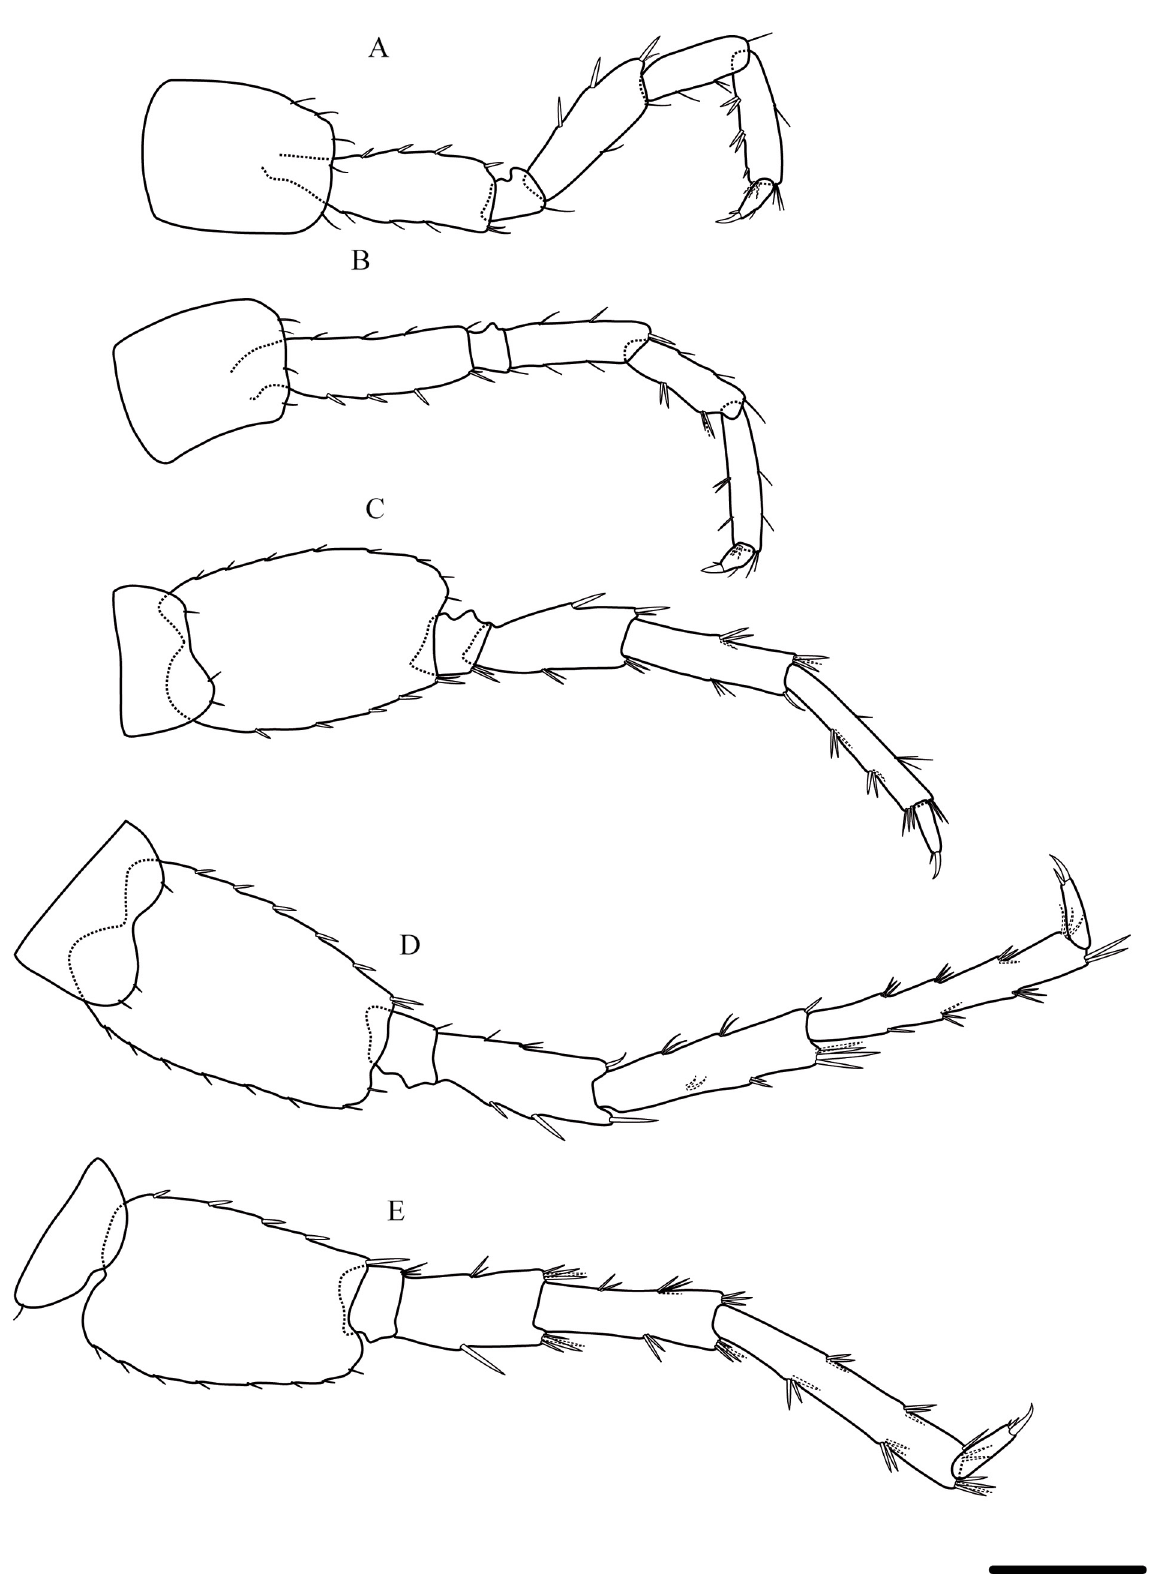
Fig. 9. Niphargus fiseri sp. nov., holotype, ♂, 8 mm (ZCRU Amph.1073). A . Pereopod III. B . Pereopod IV. C . Pereopod V. D . Pereopod VI. E . Pereopod VII. Scale bar = 1